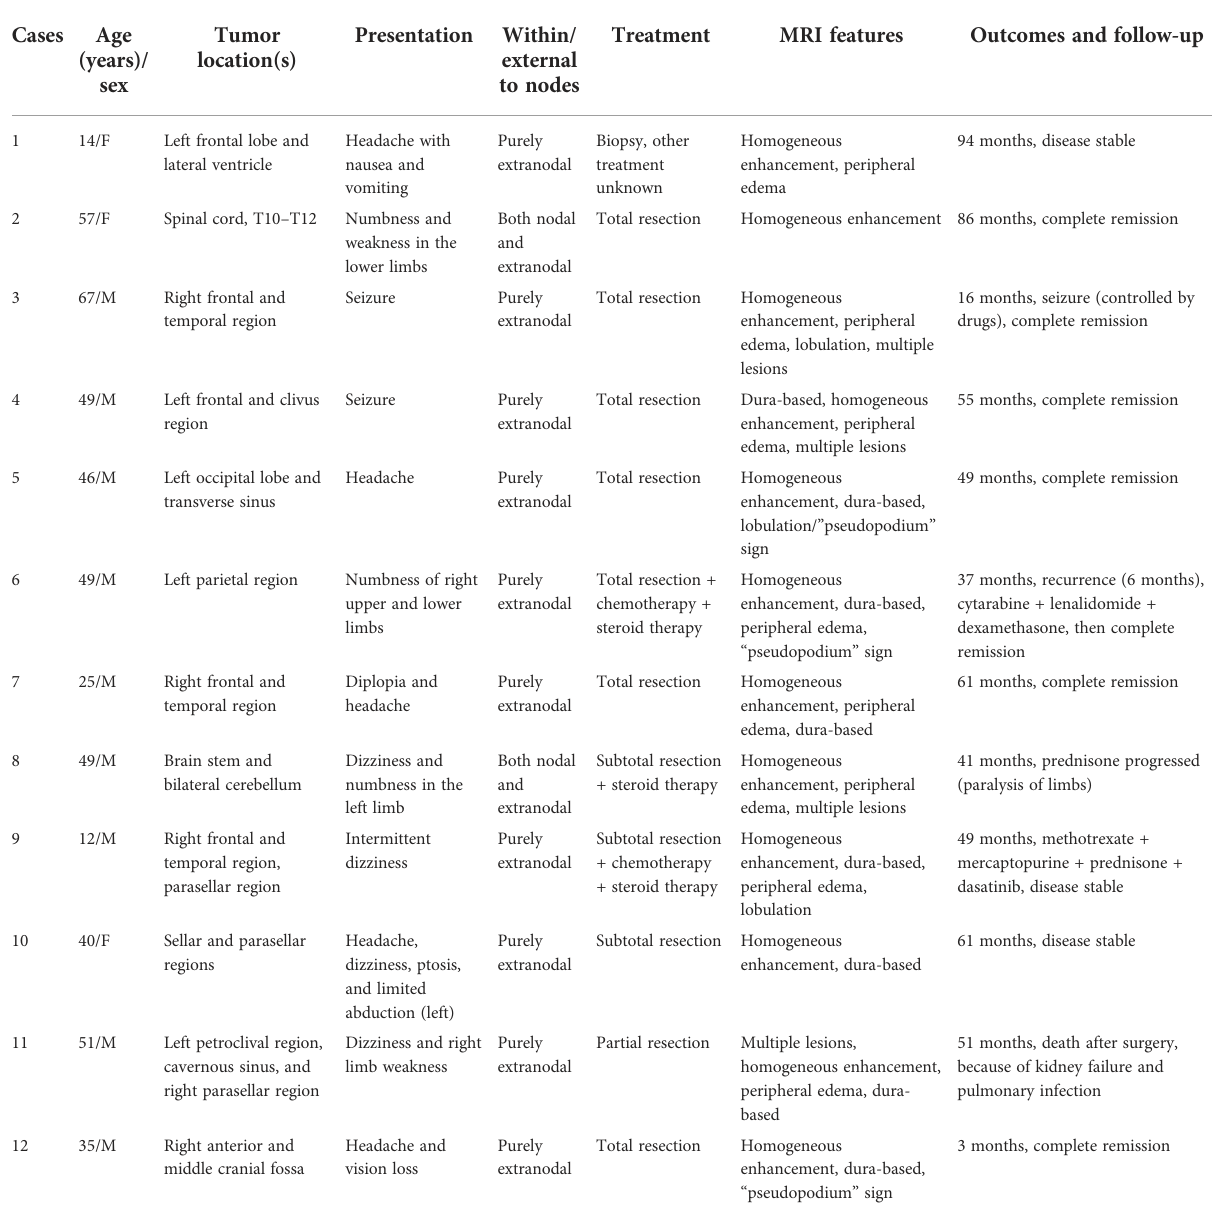
TABLE 1 Clinical pro fi le of 12 patients with RDD at presentation.